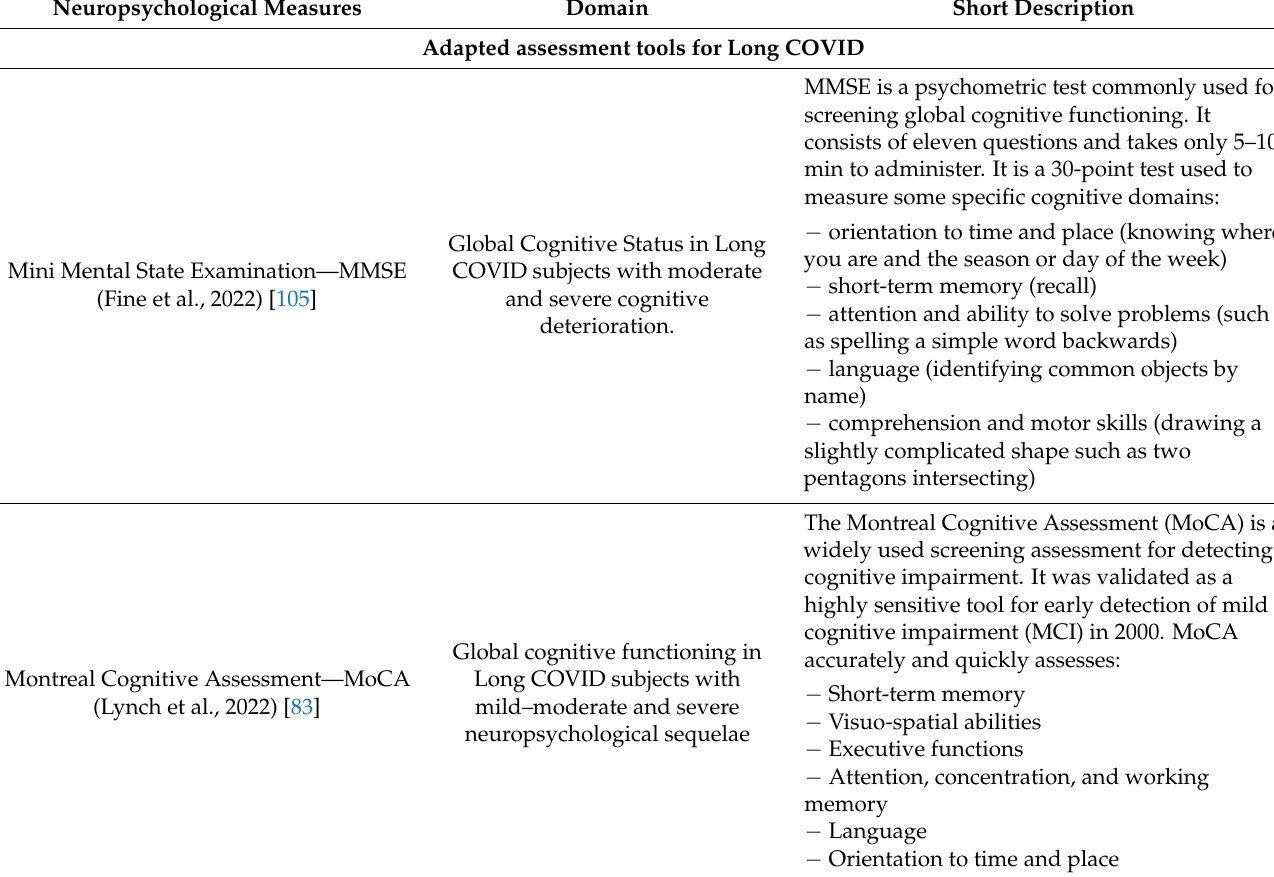
Table 1. The neuropsychological and psychological measures used to assess cognitive and behavioral alterations in Long COVID, including the non-specific “adapted” tools and newly “designed” Long COVID